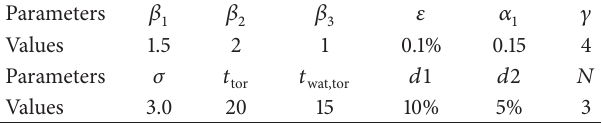
Table 3: The values of the parameter in the model. Parameters